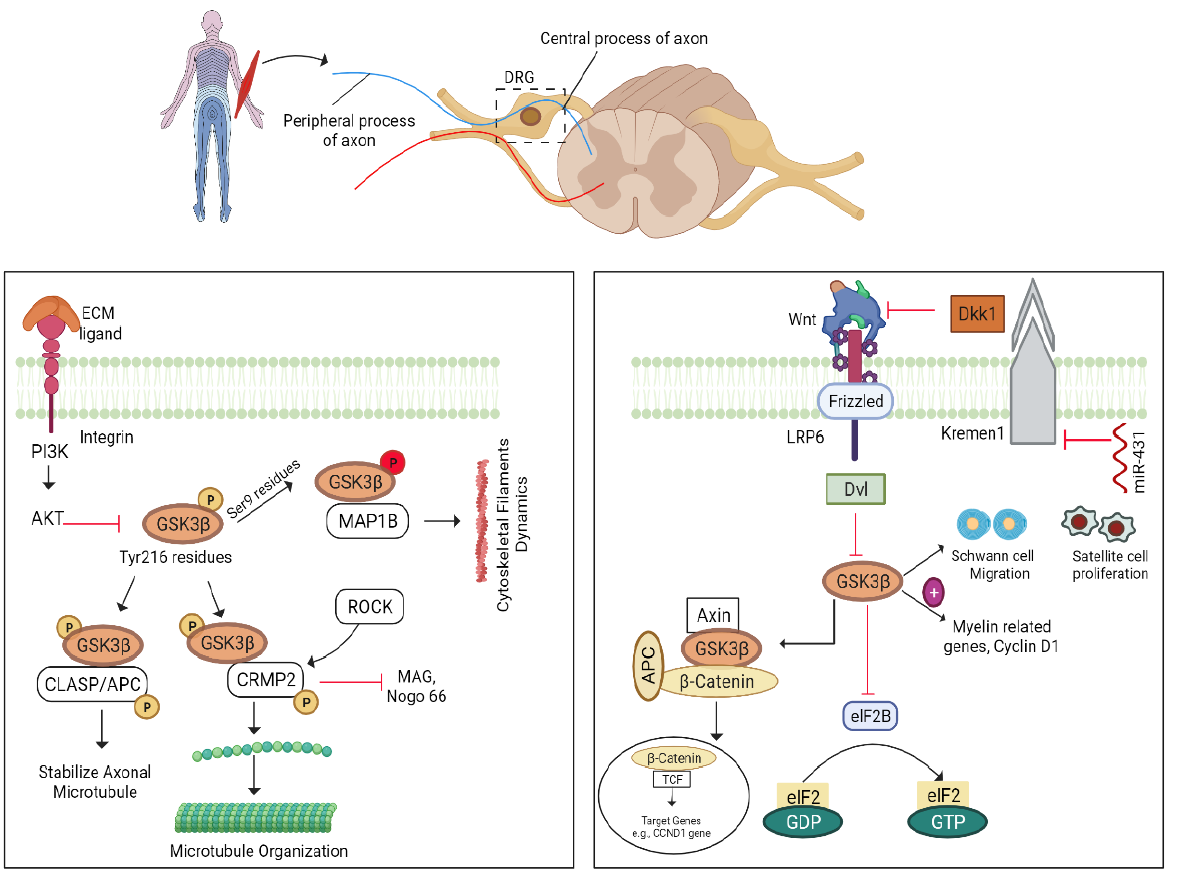
Figure 8. GSK3β mediated pathways . GSK3β mediates CLASP/APC signalling and Wnt signalling to stabilize growth cone and axon regeneration. ECM: extracellular matrix proteins; PI3K: phosphatidylinositol-3-kinase; AKT: p rotein kinase B; GSK3β: glycogen synthase kinase; CLASP/APC: clip-associated proteins/tumor suppressor protein; CRMP2: collapsin response mediator protein 2; Map1b : microtubule-associated proteins; ROCK: Rho-associated kinases; MAG/Nogo; myelin inhibitors; Wnt: protein; Dkk1: Dickkopf-1; Dvl: dishevelled proteins; GDP: guanosine diphosphate; GTP: guanosine triphosphate.